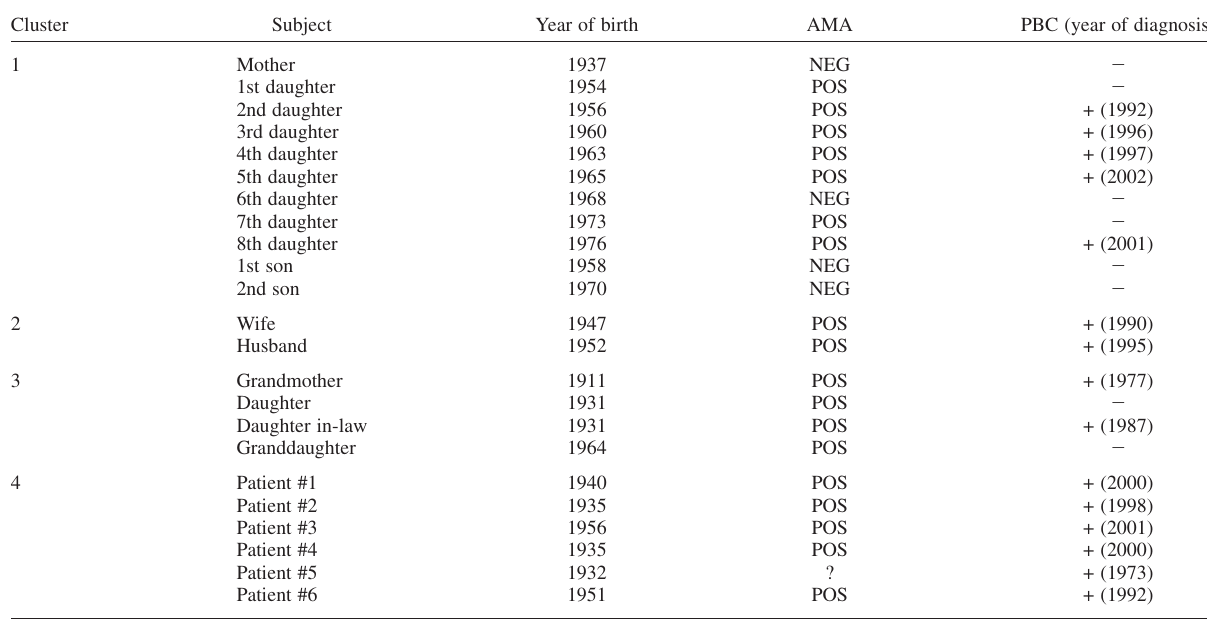
TABLE II Characteristics of the subjects included in the four PBC